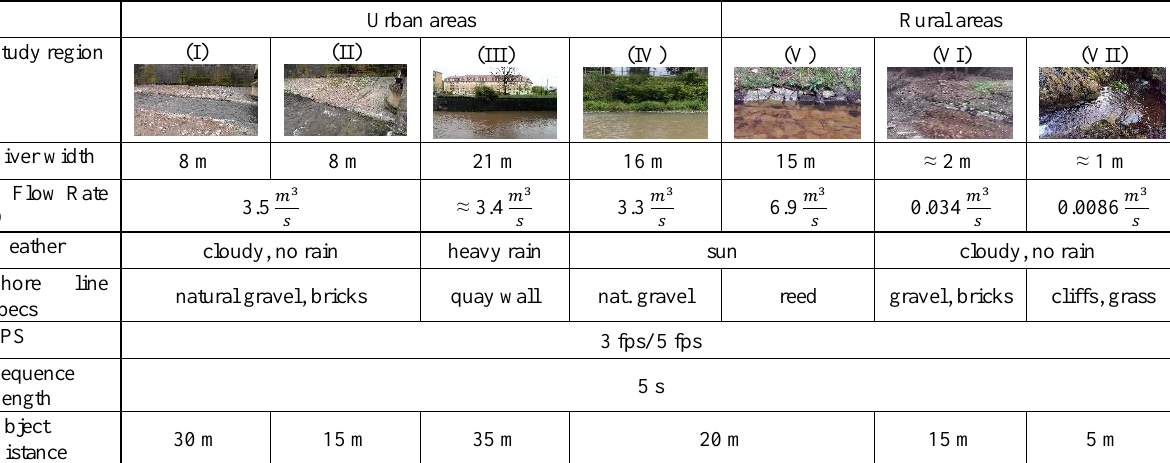
Table 1. Study areas covering urban and rural running waters regarding situative specifications of environment and camera